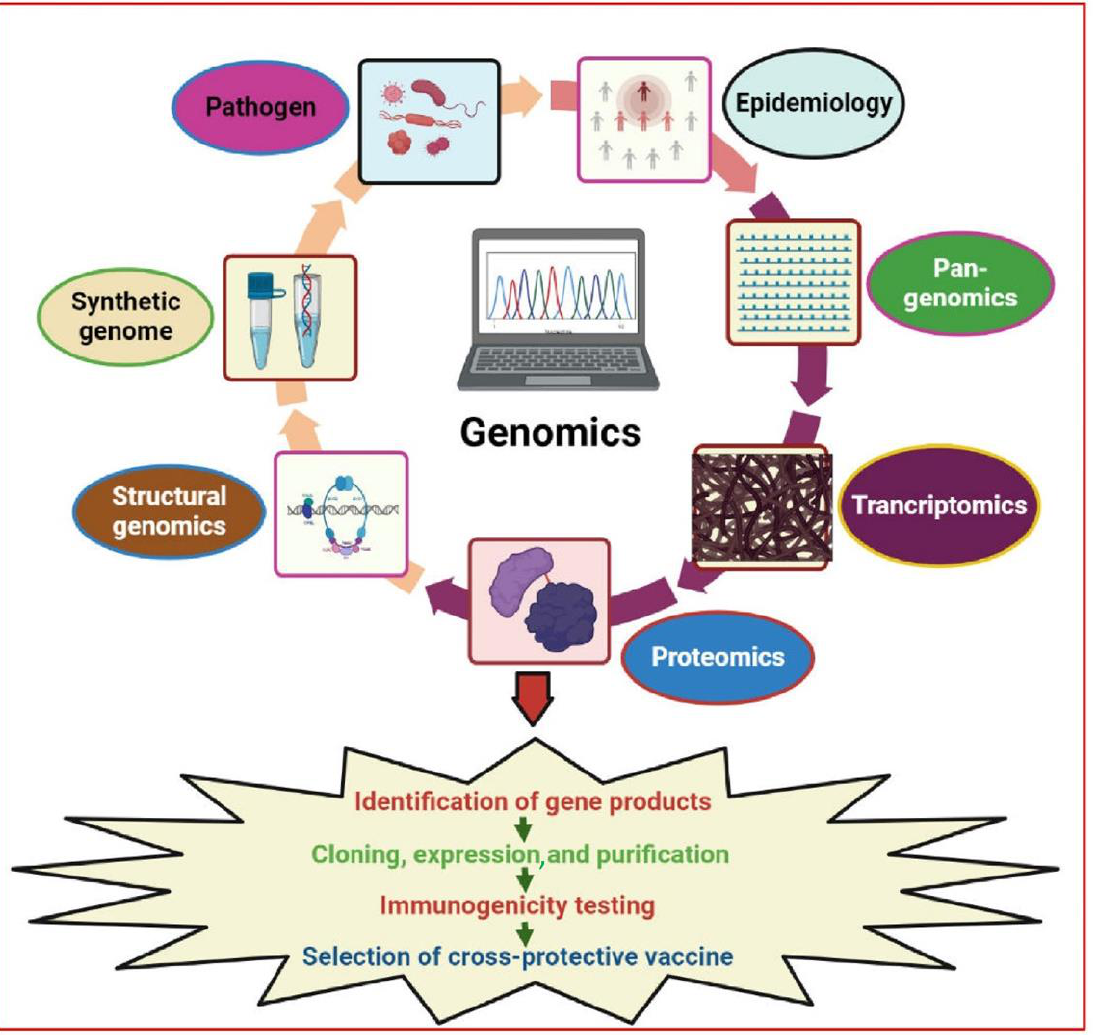
Figure 1. Illustration of major genomics strategies used for vaccine research and development. These strategies provide a more extensive selection of promising antigenic targets as compared to traditional vaccine development. Various technologies such as reverse vaccinology, comparative genomics, pan-genomics, functional genomics, structural vaccinology, and synthetic genomics were used for the identification of novel antigen targets. The figure was generated using BioRender software (biorender.com (accessed on 12 December 2022) and published under license agreement number